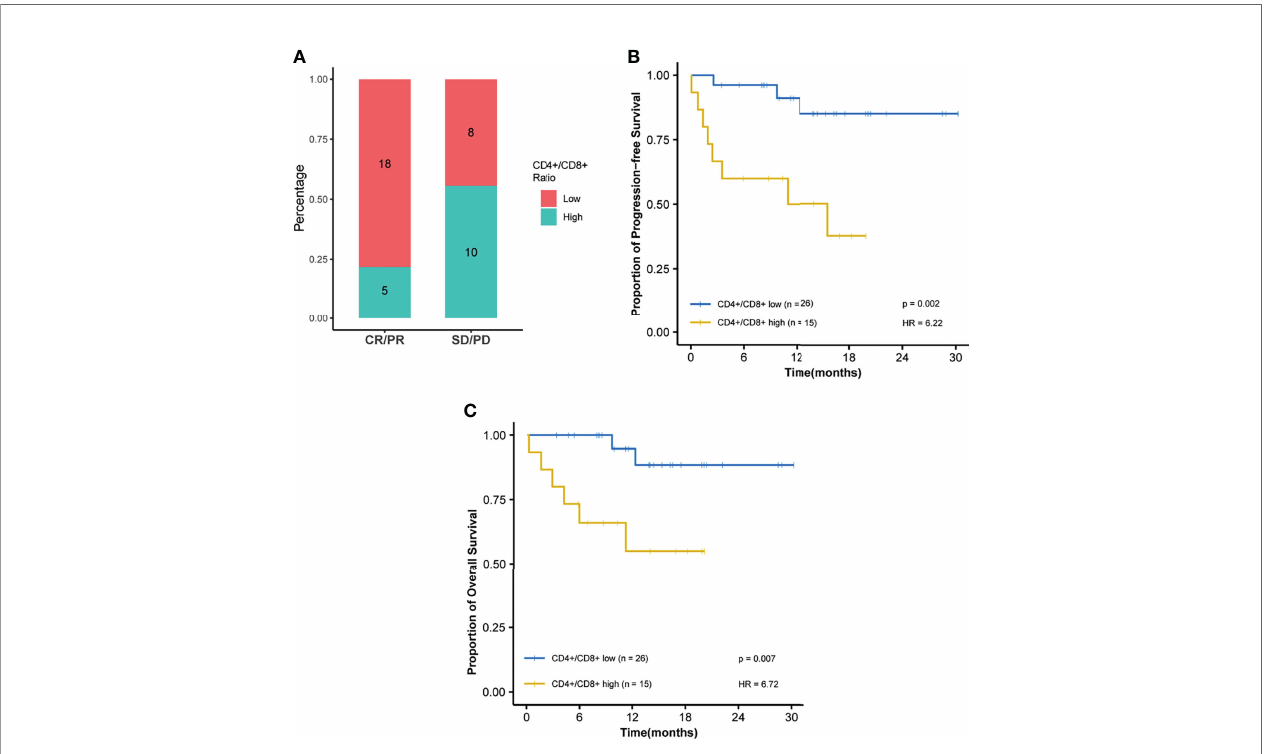
FIGURE 4 | The ratio of CD4+/CD8+ is predictive of response and survival outcome. Optimal cutoff point was calculated by receiver operating characteristic (ROC) curve analysis to dichotomize patients into high and low groups. (A) Ratio of CD4+/CD8+ distribution is visualized by a histogram between treatment response groups (CR, complete response; PR, partial response; SD, stable disease; PD, progressive disease). (B) Kaplan – Meier survival curves for progression-free survival. (C) Kaplan – Meier survival curves for overall